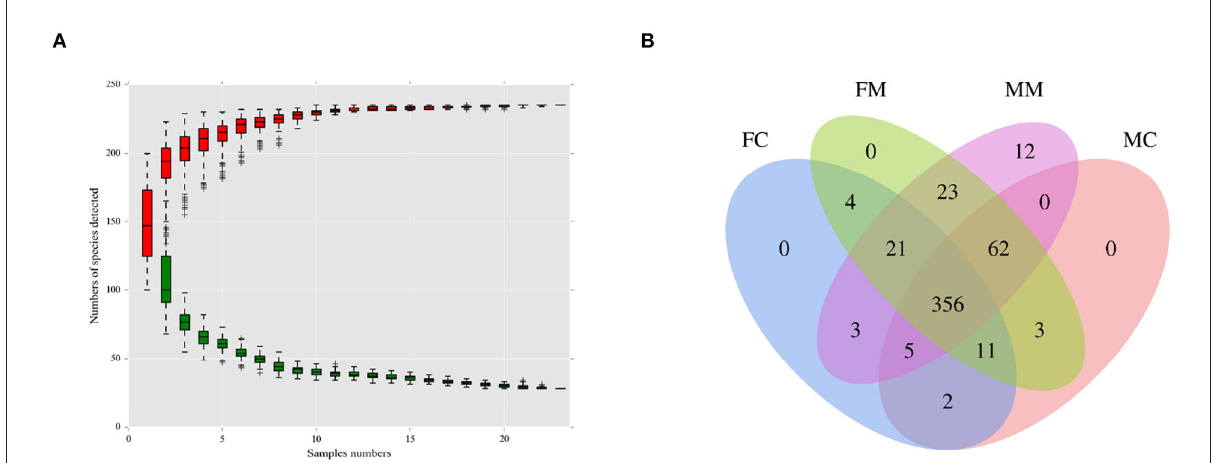
FIGURE1 (A) The species accumulation curve was used to evaluate whether the sequencing volume was sufficient to cover all taxa and reflects the species richness of the intestinal microbiota. (B) Venn diagram of each group based on the number of OTUs. FC, luminal content of female mice; FM, mucosa of female mice; MM, mucosa of male mice; MC, luminal content of male